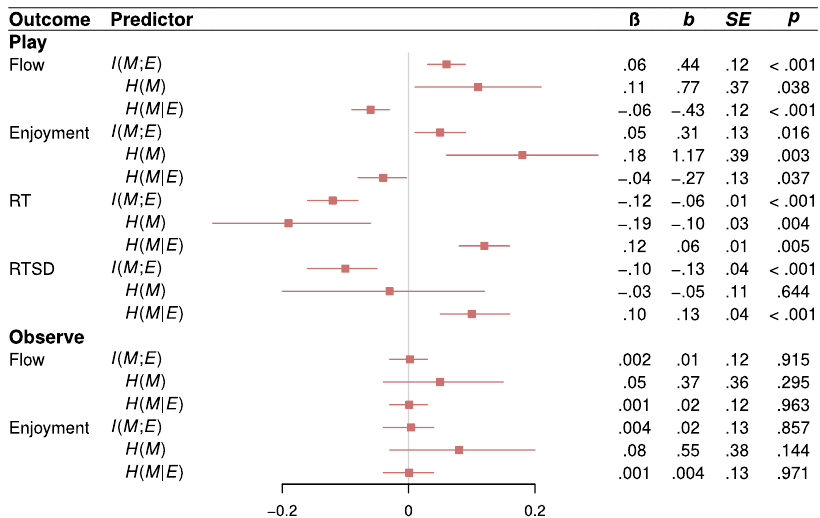
Fig. 8 Results of experiment 4. Effects of I ð M ; E Þ and its component entropy terms, H ð M Þ and H ð M j E Þ , on fl ow, enjoyment, RT, and RTSD in the both conditions (play and observe) of experiment 4. Statistics are derived from LMMs (two-sided) performed over 1882 observations across 941 participants. Each LMM regresses one variable from the outcome column on one variable from the predictor column (with the exception of H M ð Þ and H M j E ð Þ , which are included in the same model), a nuisance regressor for game order ( fi rst game vs. second game), and random subject-level intercepts. LMMs predicting RT and RTSD also include a nuisance regressor for p M ð hit Þ to control for task demands on response time. Red squares denote standardized regression coef fi cients, and intersecting red lines represent 95% CIs. No corrections for multiple comparisons were applied.